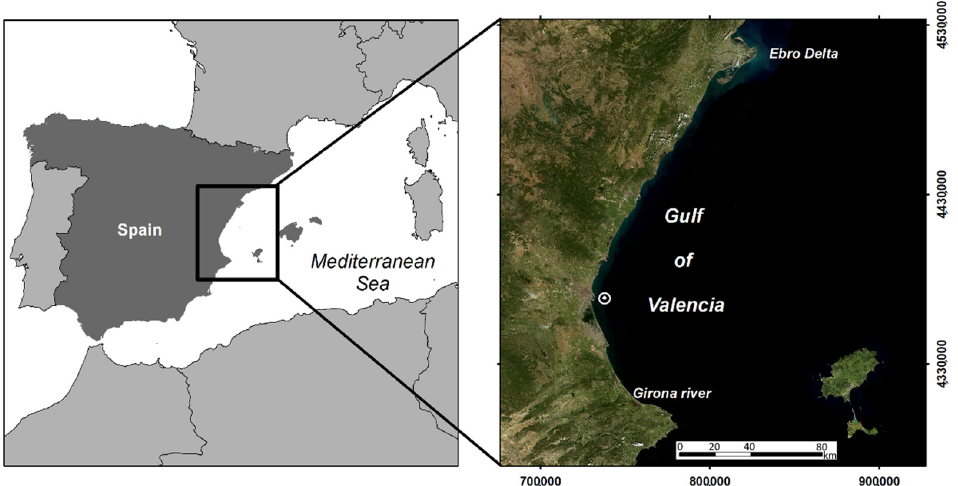
Figure 1. Regional setting covering the beaches along the Gulf of Valencia (W Mediterranean), between the Ebro Delta and the mouth of the Girona river. The white point indicates the SIMAR point for which the historical wave data has been acquired.